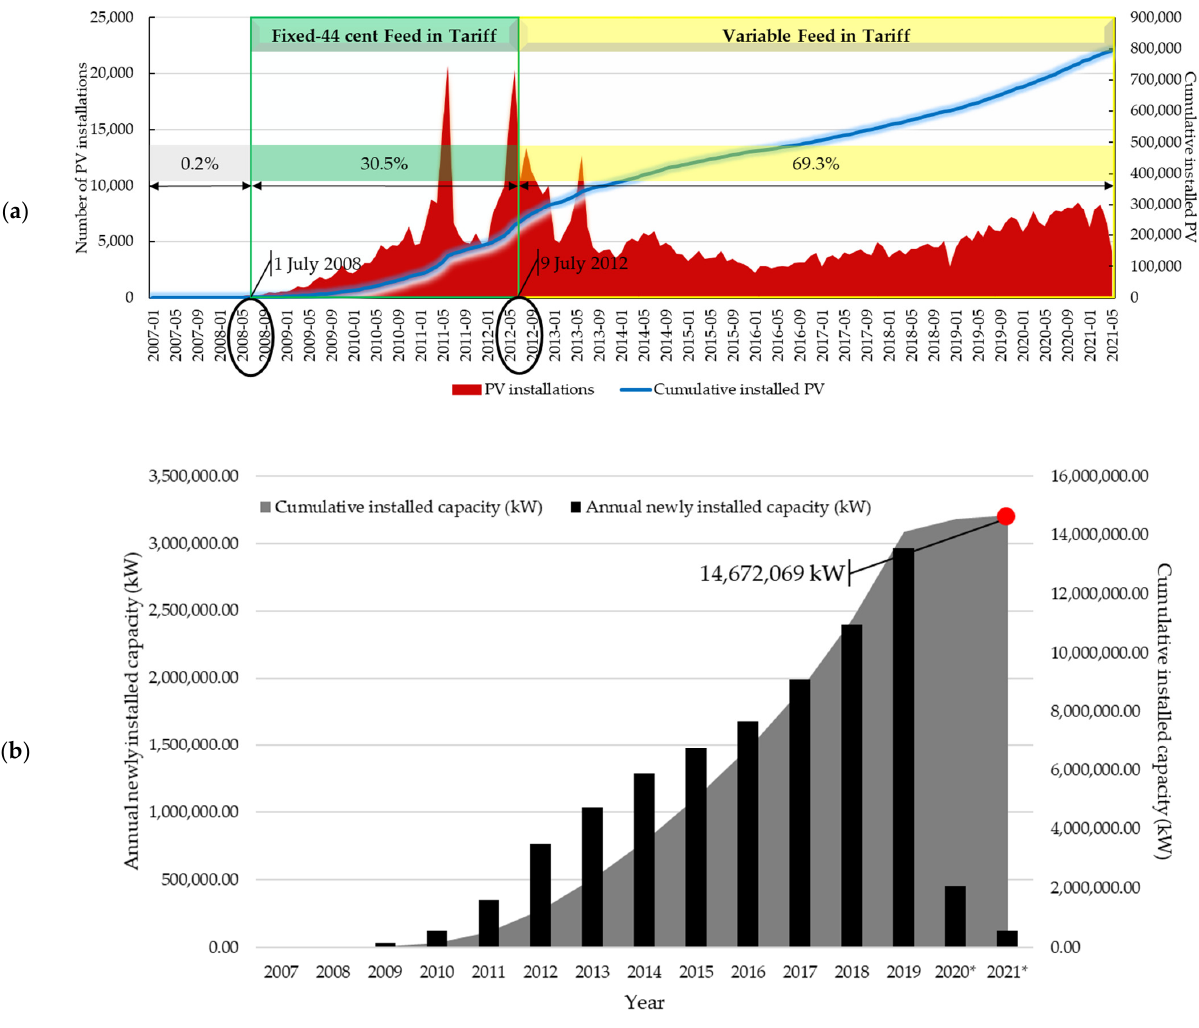
Figure 3. ( a ) The number of residential solar PV installations in Queensland, Australia, by the FiT rate (the percentage refers to the proportion of the adoption rate for each period); ( b ) power capacity from these installations (* the data for 2021 and 2021 are not finalised and represent only the available data) (data adapted from [18]).